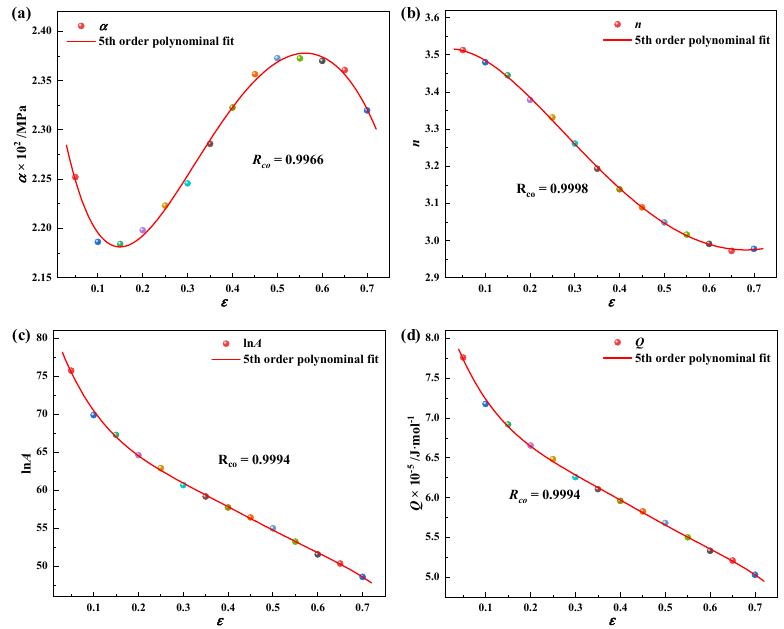
. . . ε − σ ; ( b ) ln ε − ln σ ; ( c ) ln ε − ln [ sinh ( ασ )] ;